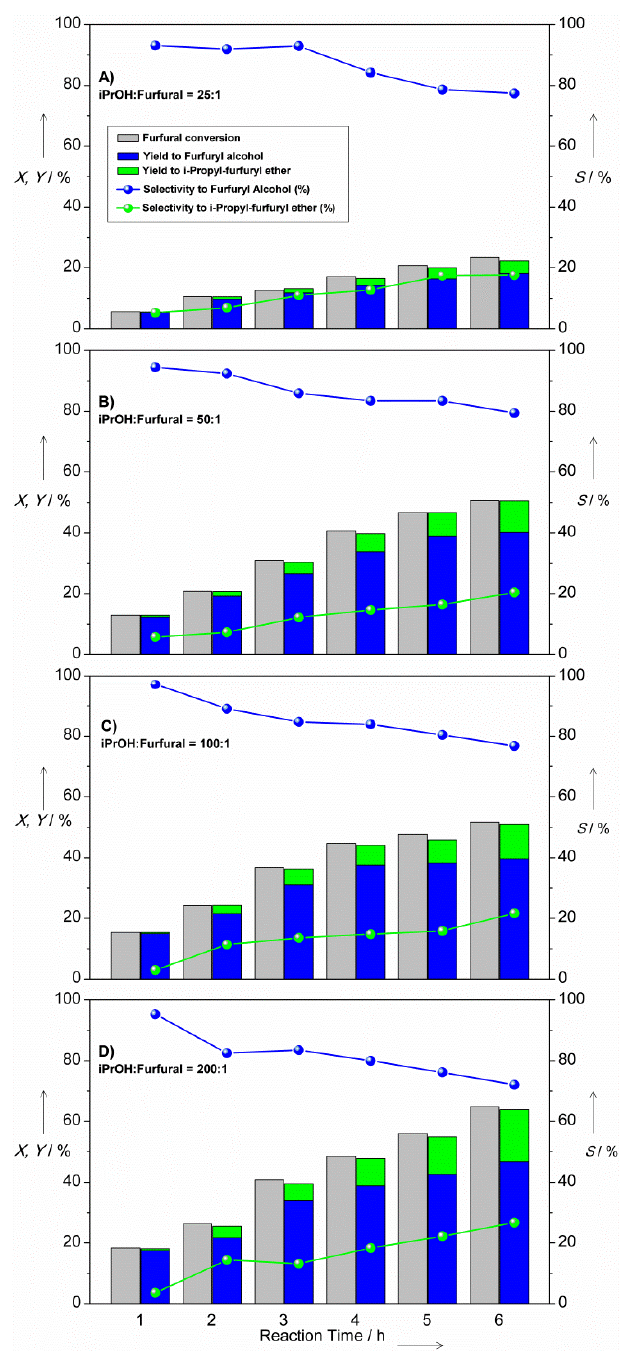
Figure 4. MPV reduction of furfural with i -PrOH in presence of Zr-SBA-15—influence of the sacrificing alcohol to substrate molar ratio. Reaction Conditions: Catalyst loading: 0.2 g; reaction temperature: 90 °C; furfural to catalyst mass ratio: 1.0; i -PrOH to furfural molar ratio: ( A ) 25:1, ( B ) 50:1; ( C ) 100:1; ( D ) 200:1. (X = Substrate conversion; Y = Product Yield; S = Selectivity towards the